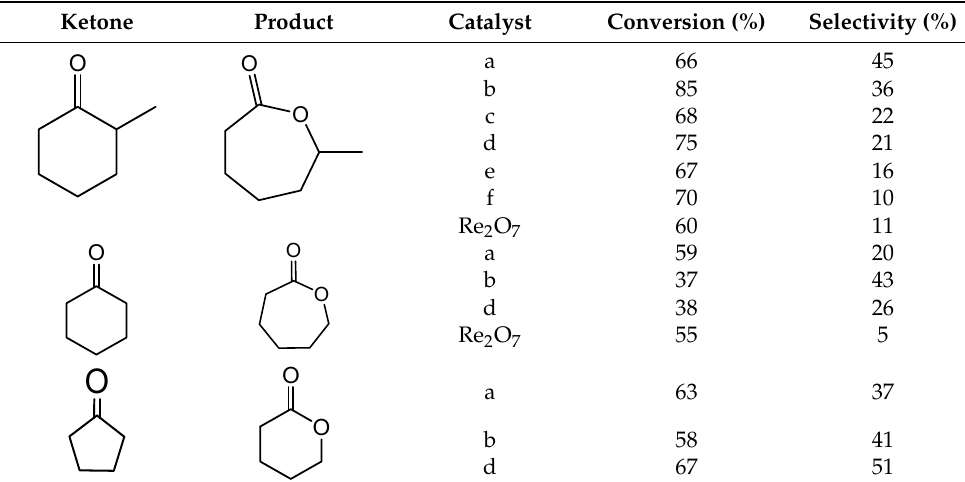
Table 2. Catalytic performance of (P-P)Pt(CF 3 )X for the oxidation of cyclic ketones to lactones. Ketone